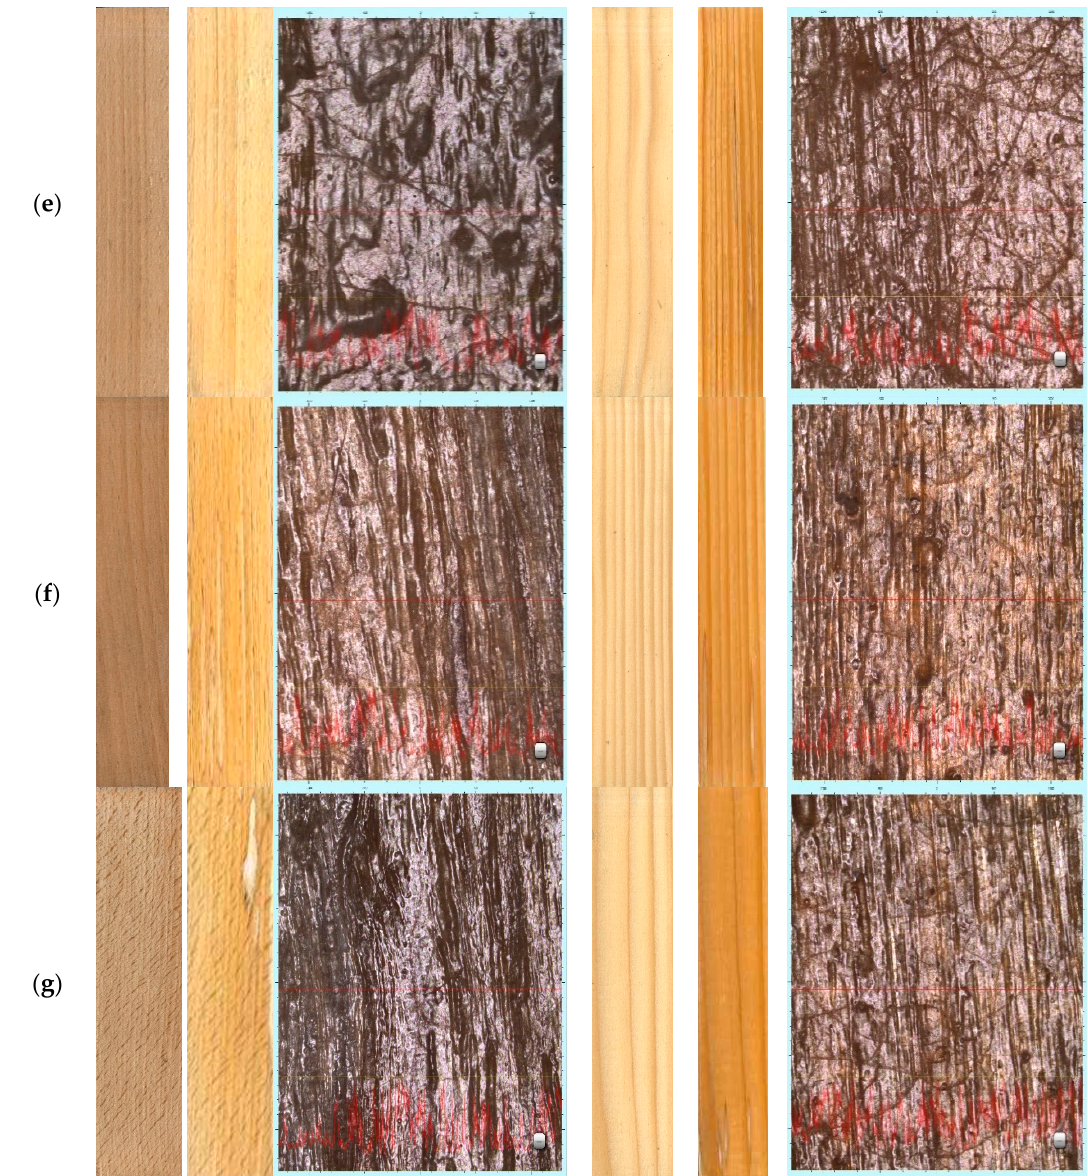
Figure 1. Beech (left) and spruce (right) wood samples before (0.w.) and after accelerated weathering (AW) (6.w.). ( a ) Reference native wood (R-R); ( b ) acrylic coating on untreated wood (R-A); ( c ) acrylic coating on caffeine treated wood (5-A); ( d ) acrylic coating on wood treated with 10% FN-NANO ® (1-A); ( e ) acrylic coating on wood treated with 15% FN-NANO ® (2-A); ( f ) acrylic coating on wood treated with a mixture of 10% FN-NANO ® and 1% of caffeine (3-A); ( g ) acrylic coating on wood treated with a mixture of 15% FN-NANO ® and 1% of caffeine (4-A). Note: The real observed area of microscopic picture was 2500 μ m × 2500 μ m using 108-folder magnification.